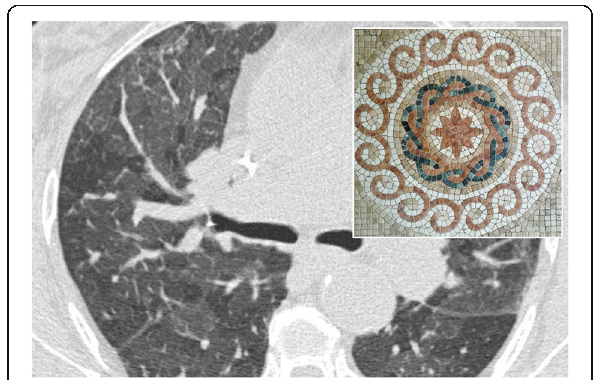
Fig. 23 Mosaic attenuation. Mosaic pattern in a patient affected by asthma. Lung parenchyma shows different attenuation areas, due to presence of pulmonary lobules with decreased density, caused by air-trapping. This appearance recalls a mosaic, as clearly evident in the embedded